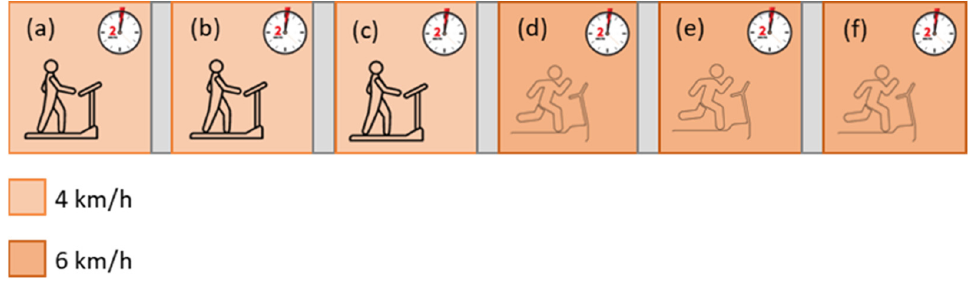
Figure 2. Laboratory test protocol (after initial recording at rest): exercises on treadmill, at two different velocities, namely 4 km/h ( a – c ) and 6 km/h ( d – f ).